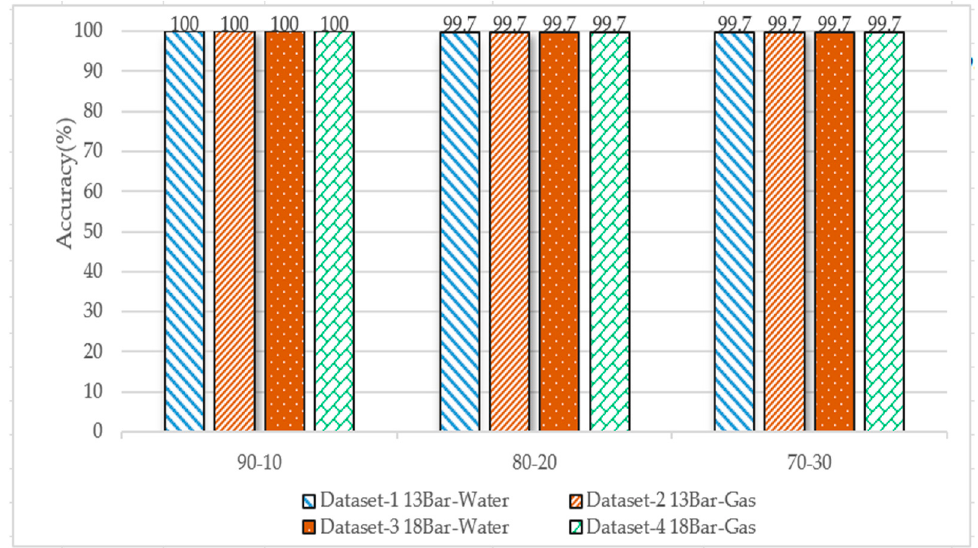
Figure 15. Performance comparison of random forest algorithm accuracy for the four datasets and for the different data splits (No. of Trees = 100; Gini index split).